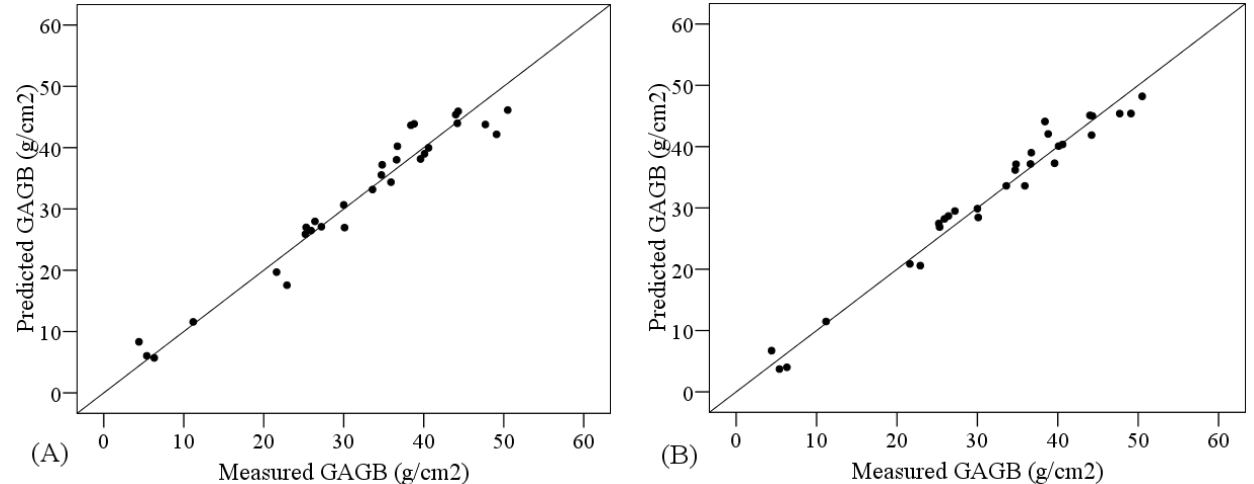
Figure 5. Cross-calibration results for predicting GAGB using ( A ) PLSR based on the continuum-removed AOM index and ( B ) SVM based on VNIR + SWIR1 + SWIR2. One-to-one line is